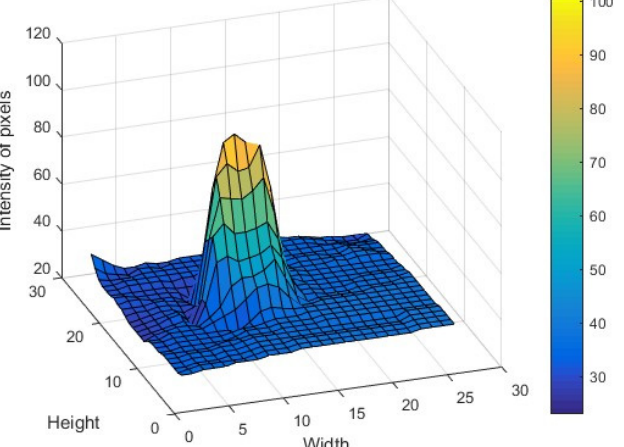
Figure 9. Intensity distribution of the focus spots in an image pattern for the tested eye. Width and height are in pixels.